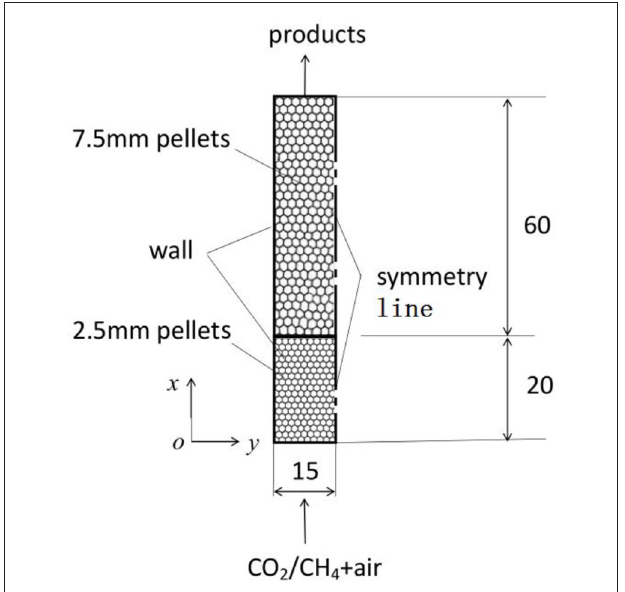
FIGURE 1 | Schematic of the two-layer burner. All dimensions are in